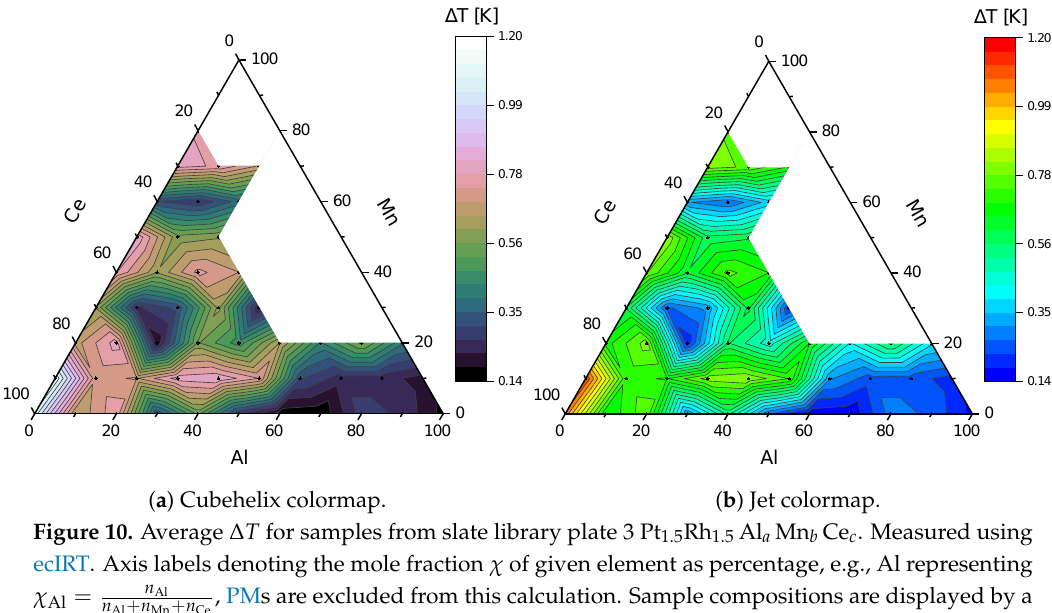
Figure 9. Results of ecIRT measurement for slate library plate 3 containing 104 samples from composition range Pt 1.5 Rh 1.5 Al a Mn b Ce c , displayed using different colormaps. 2vol.% CH 4 , 8vol.% O 2 , 12vol.% H 2 O, balance N 2 , 400 ◦ C.